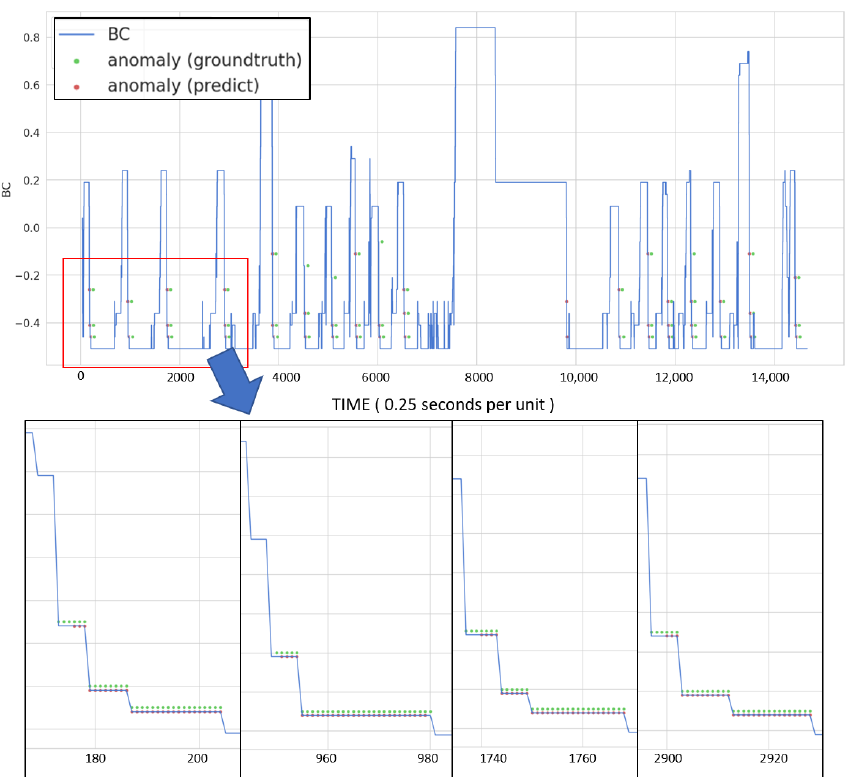
Figure 4. Predicted anomaly points using our proposed model and the labeled anomaly